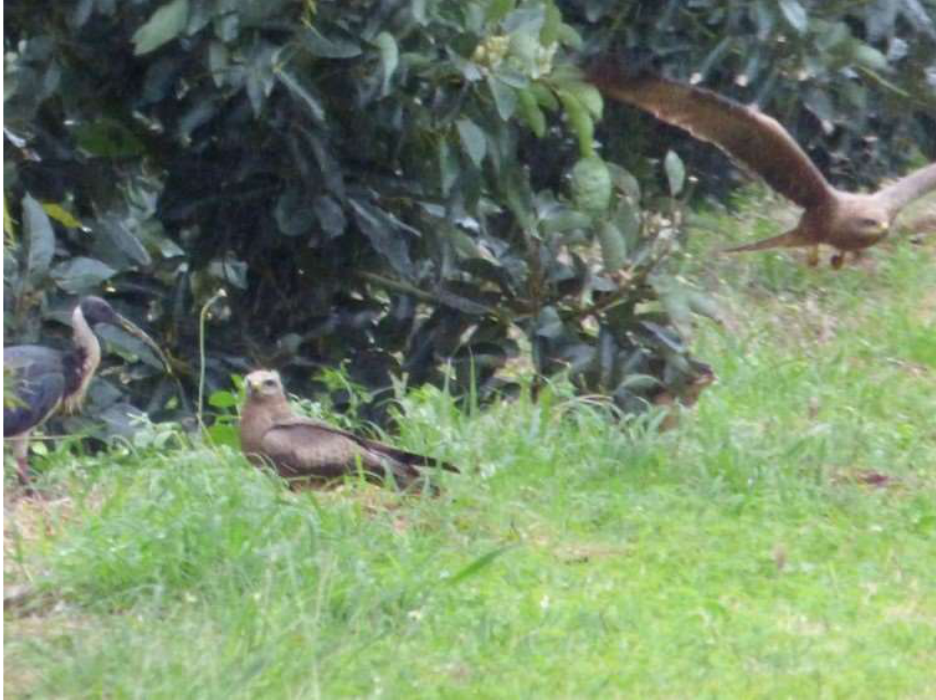
Figure 3. Straw-necked Ibis competing with Black Kites for fallen avocado fruits, Mareeba, Queens- land, Australia (see also Supplementary video S1). Photo: Jack Leighton.